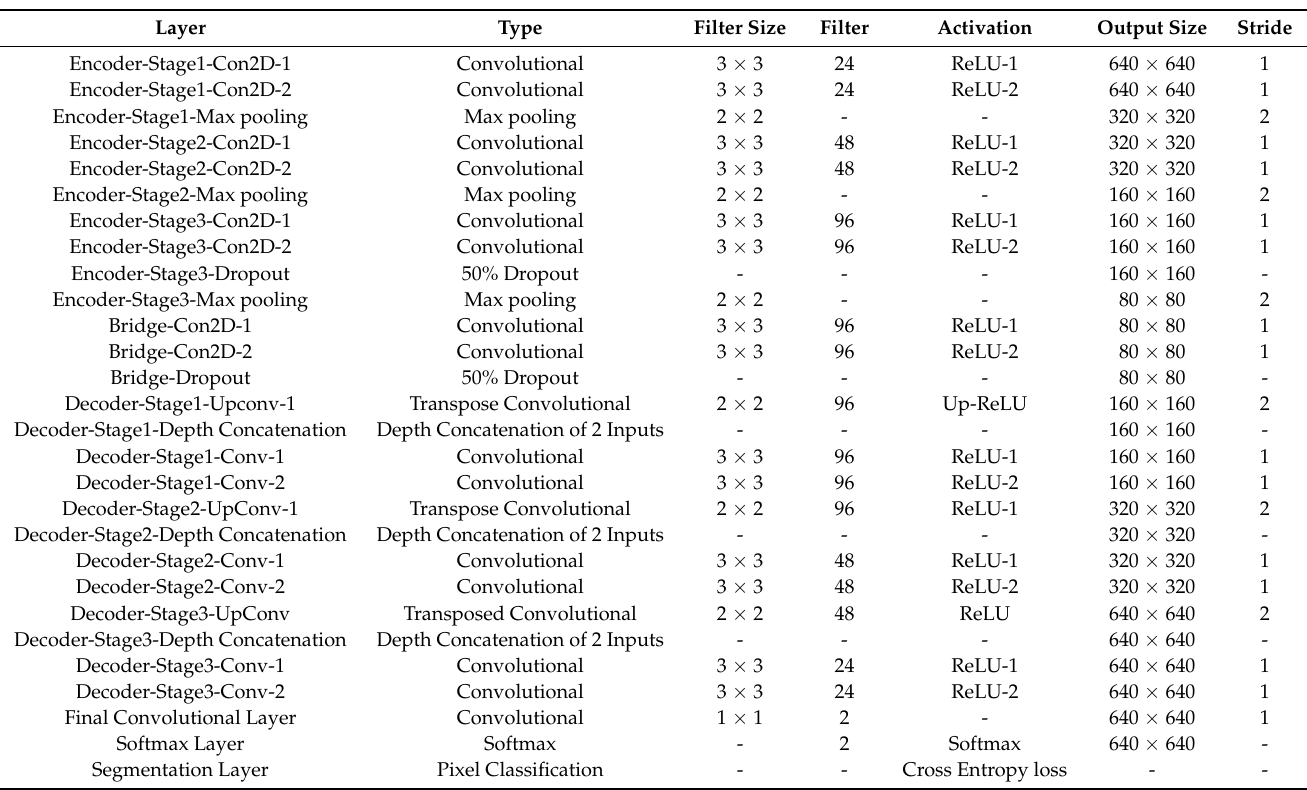
Table 1. Proposed LUVS-Net filter details.